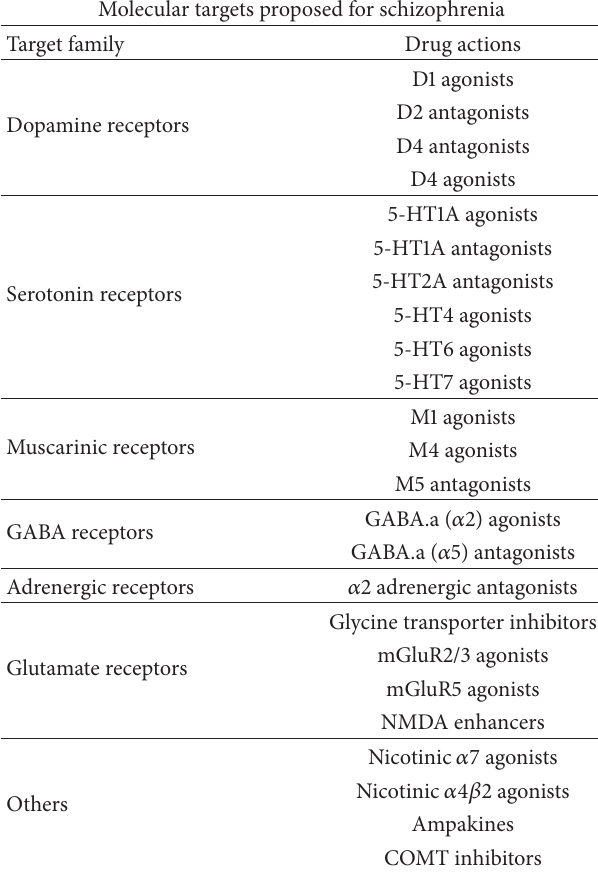
Table 1: Potential molecular targets in